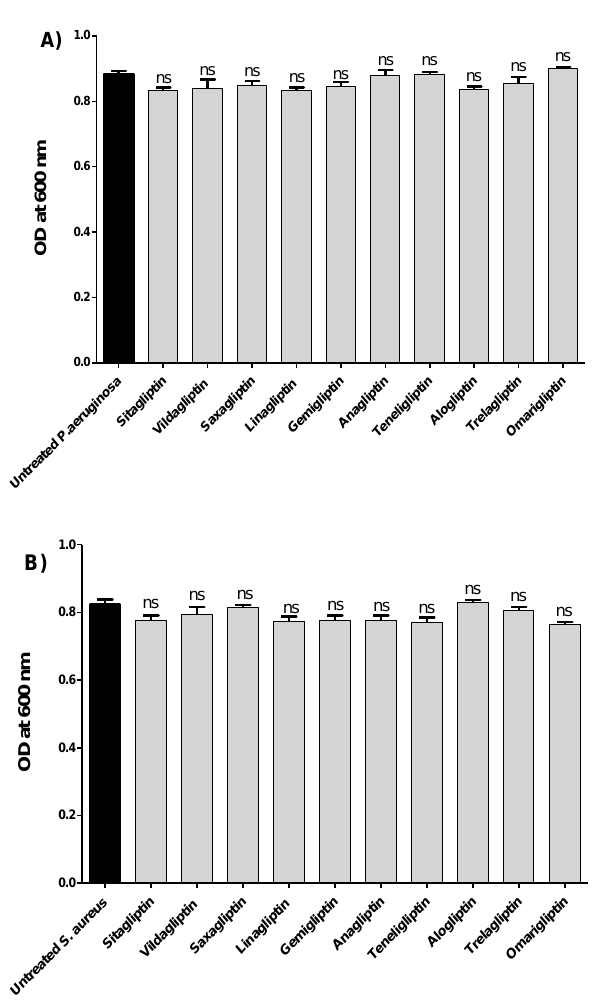
Figure 1. Effect of gliptins on bacterial growth. The turbidities of bacterial growth were measured at OD 600 nm in the presence or absence of gliptins at sub-MICs (1/5 MIC). The experiment was repeated in triplicate, data are presented as mean ± SD, and two-way ANOVA test followed by Bonferroni post-test was employed to test significance. There was no significant effect of tested gliptins at their sub-MICs on the growth of ( A ) P. aeruginosa or ( B ) S. aureus . ns: non-significant.